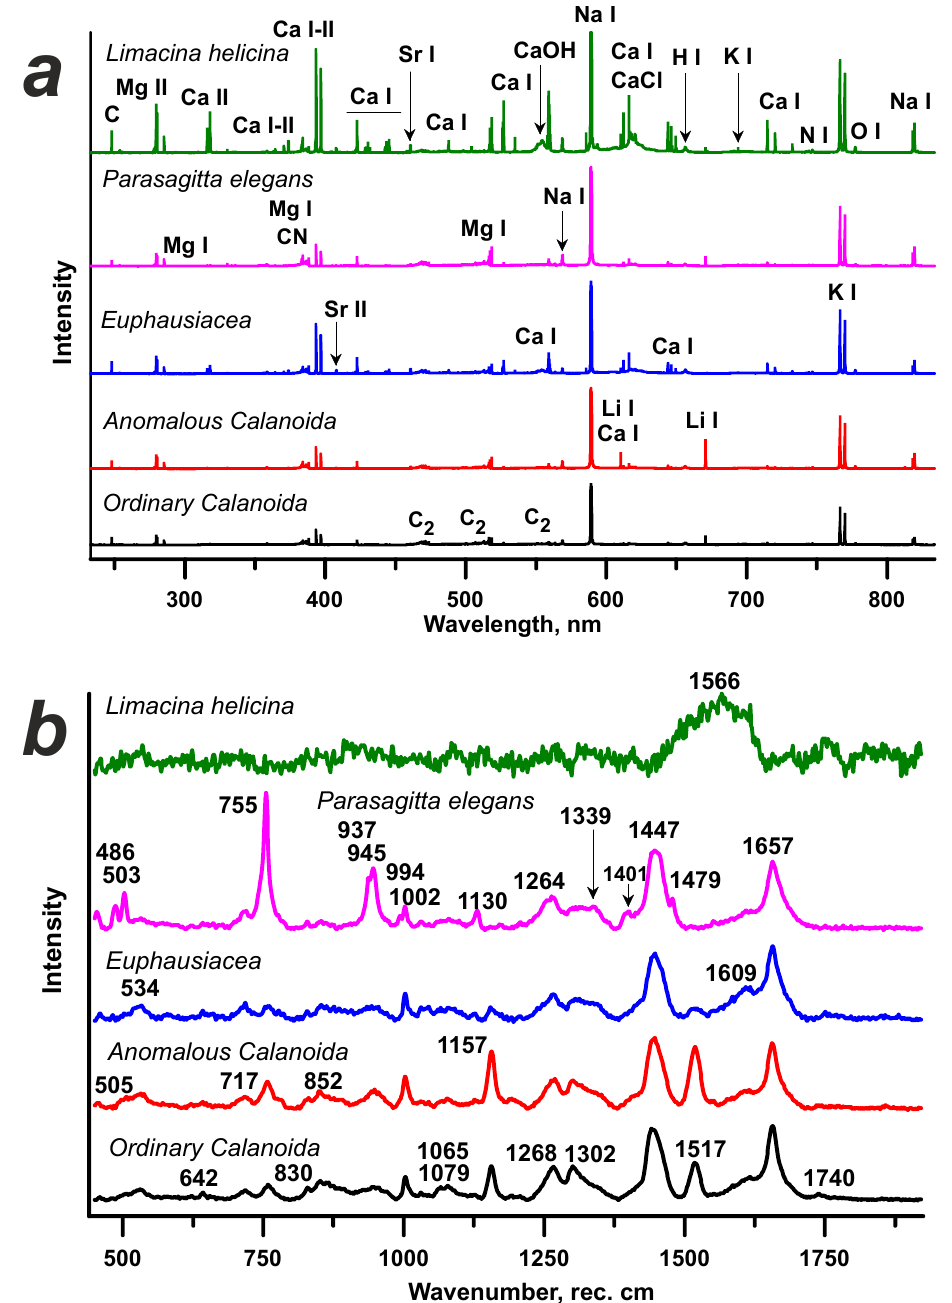
Figure 1. Overview ( a ) LIBS and ( b ) Raman spectra of the studied animals (all from medium-coloured spots). The spectra are averaged over the respective taxa. Conversely, the Raman spectra of Limacina (Figure 1b) are feeble and not very in- formative. Parasagitta present distinct amino acid features such as those at 755 cm −1 (probably corresponding to tryptophan) and 945 cm −1 (valine), accompanied by sharp peaks at 486, 503, and 3013 cm −1 (probably NH 2 groups). In Euphausiacea , relatively strong signals at 1609 cm −1 appear (phenyl rings) [67]. Calanoida show strong bands of carotenoid pigments at 1004, 1157, and 1518 cm −1 . Nearly all the animals show strong bands of sat- urated and unsaturated fatty acids at 1446 and 1656 cm −1 , respectively [67,68]. These